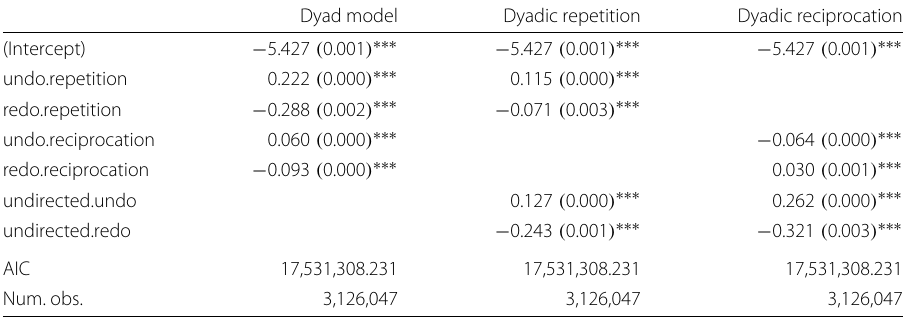
Table 3 Explaining dyadic undo by past dyadic undo and past dyadic redo on the same dyad Dyad model Dyadic repetition Dyadic reciprocation (Intercept) − 5.427 ( 0.001 )